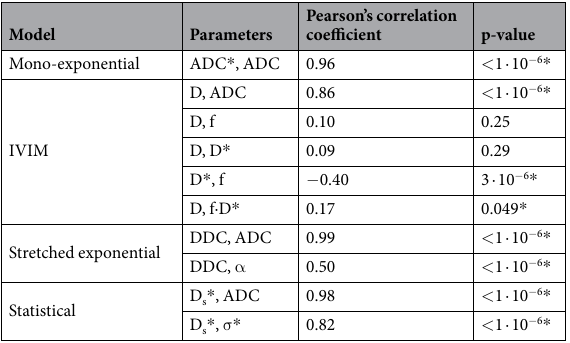
Table 4. Pearson’s correlation coefficients and corresponding p-values between the various diffusion parameters. Statistically significant values are designated by an asterisk.